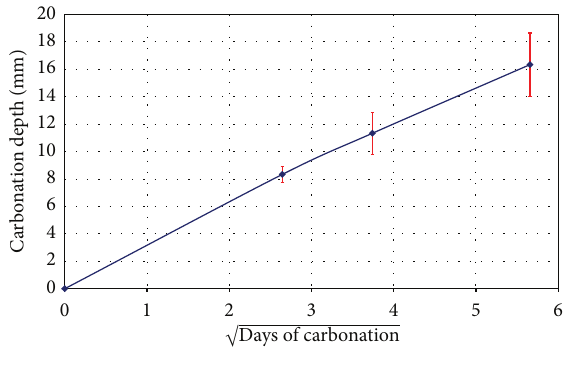
Figure 7: Evolution of the carbonation depth during carbonation.